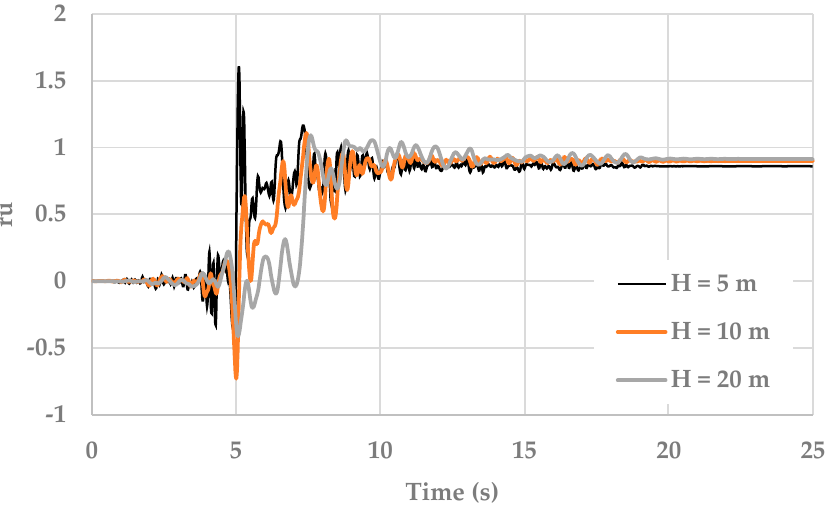
Figure 5. Effect of the thickness of the liquefiable layer on the pore water pressure ratio (ru)-time history for the case of a building resting on medium sand and subjected to LOS earthquake shake.